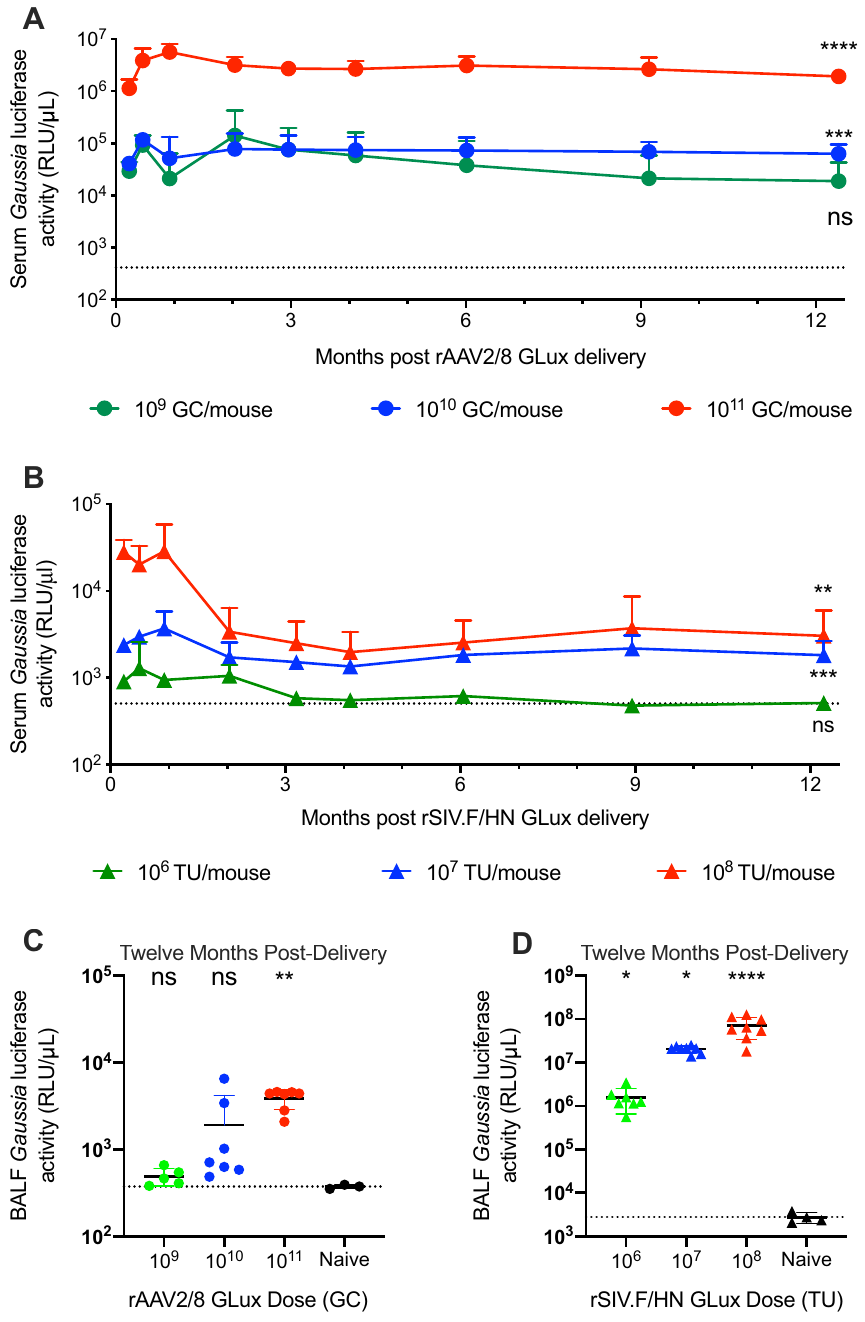
Figure 2. In vivo production of Gaussia Luciferase from rAAV2/8 and rSIV.F/HN ( A ) Female BALB/c mice were administered 10 9 (green circles), 10 10 (blue circles) or 10 11 (red circles) Genome Copies (GC) of rAAV2/8 CASI Glux via intramuscular (IM) injection (n = 12/group) or were naïve to treatment (n = 22); or, ( B ) 10 6 (green triangles), 10 7 (blue triangles) or 10 8 (red triangles) Transducing Units (TU) of rSIV.F/HN hCEF GLux via intranasal (IN) instillation (n = 11/group) or were naïve to treatment (n = 16). GLux activity was determined in serum was obtained via tail vein bleeding at the indicated time-points. Individual values for GLux activity in BALF samples from ( C ) rAAV2/8 and ( D ) rSIV.F/HN treatment groups was determined at the end of the study (approximately 12 months post vector delivery; n = 3–8/group from groups described in A & B ). The dotted line represents the mean naïve value. Differences between treatment groups and naïve animals were evaluated using the Kruskal–Wallis test with Dunn’s post hoc multiple comparison